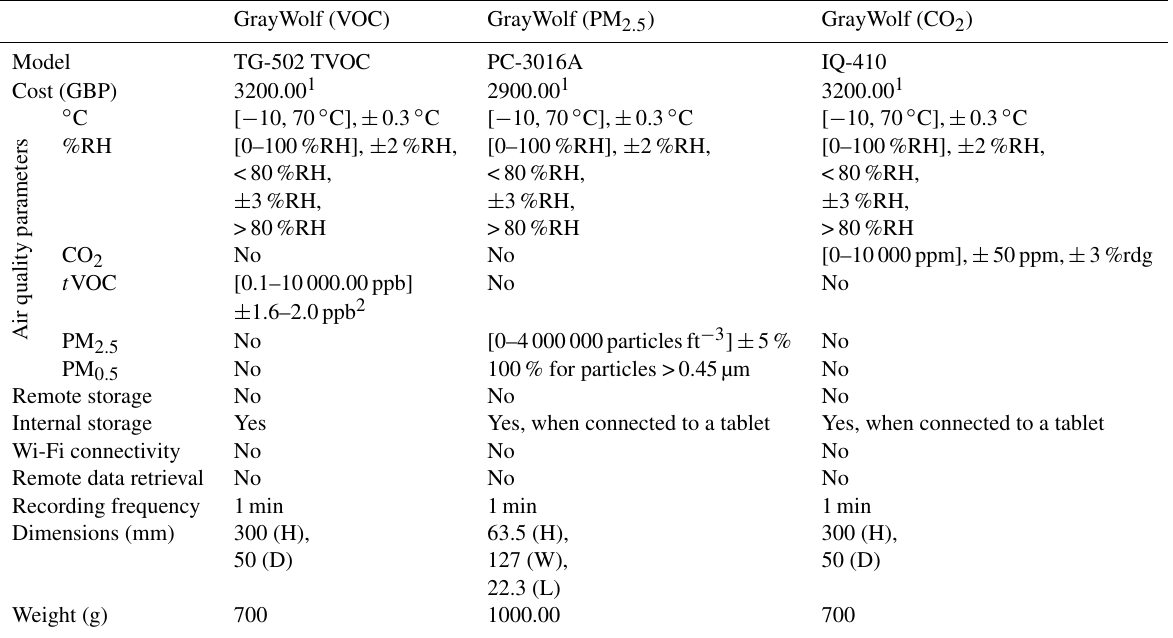
Table 2. Manufacturer specifications and characteristics for the GrayWolf